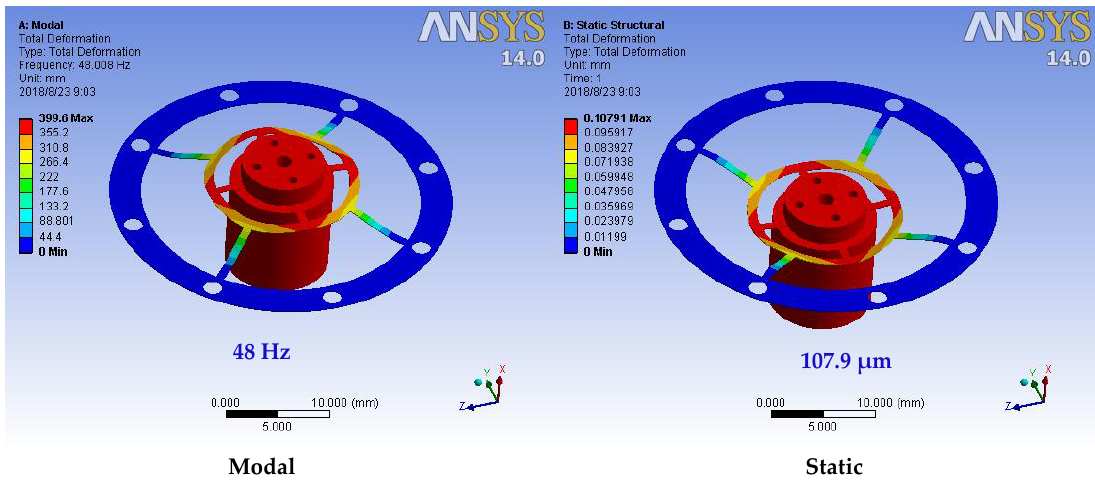
Figure 4. The modal and static structural analysis result of simulation software ANSYS (shape c).